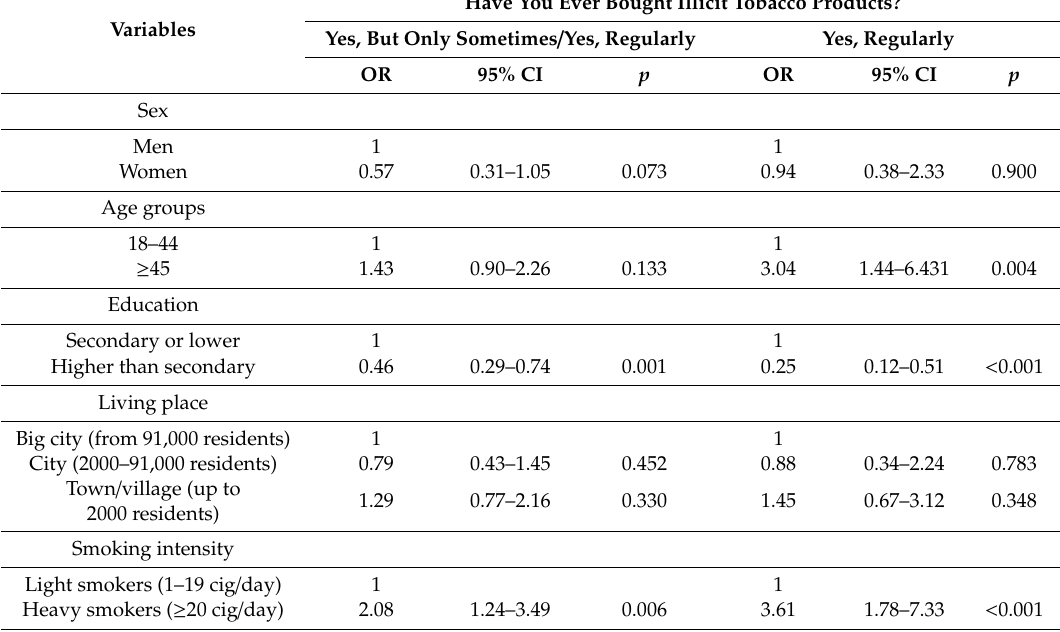
Table 3. Odds ratios of purchase of illicit tobacco products according to socio-demographic characteristics and smoking